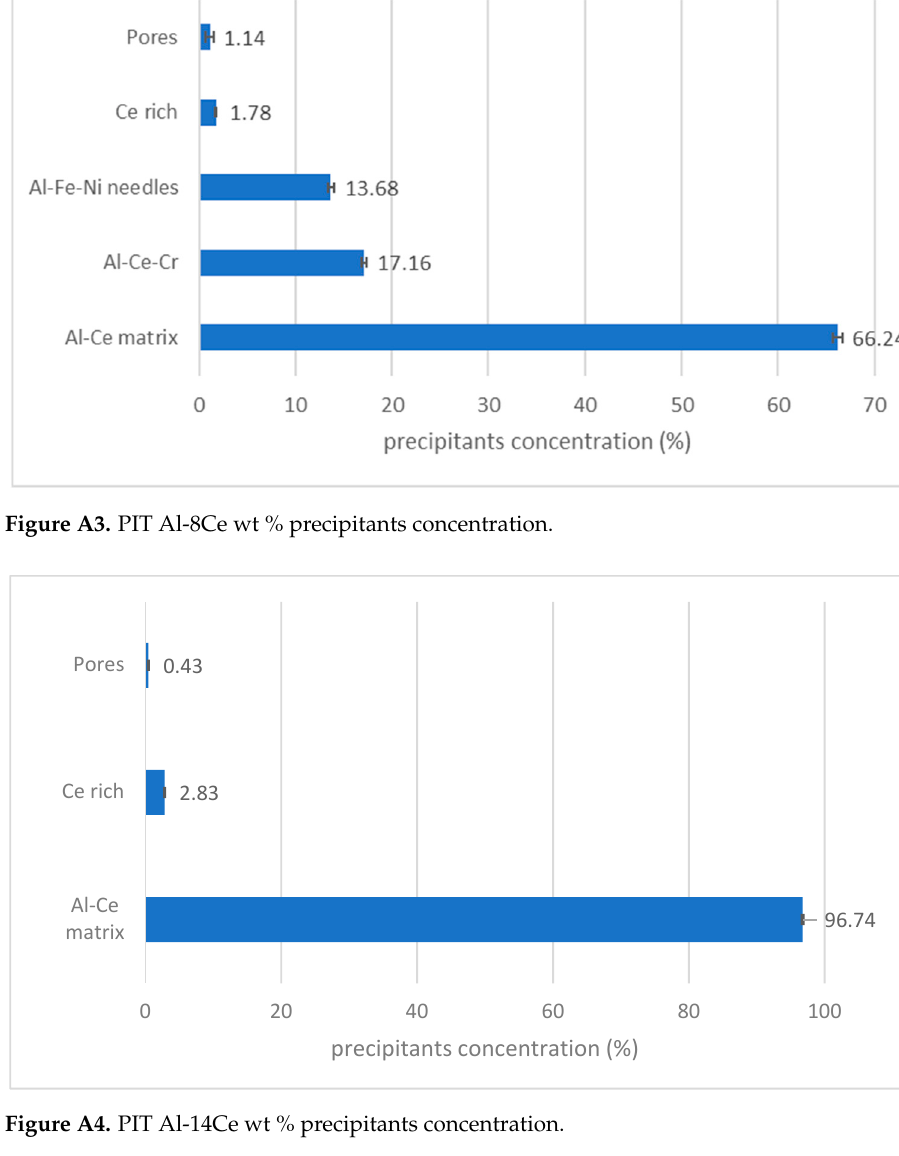
8 Table A2. Test matrix PIT Al-8Ce-10Mg wt % experiments. No. Samples